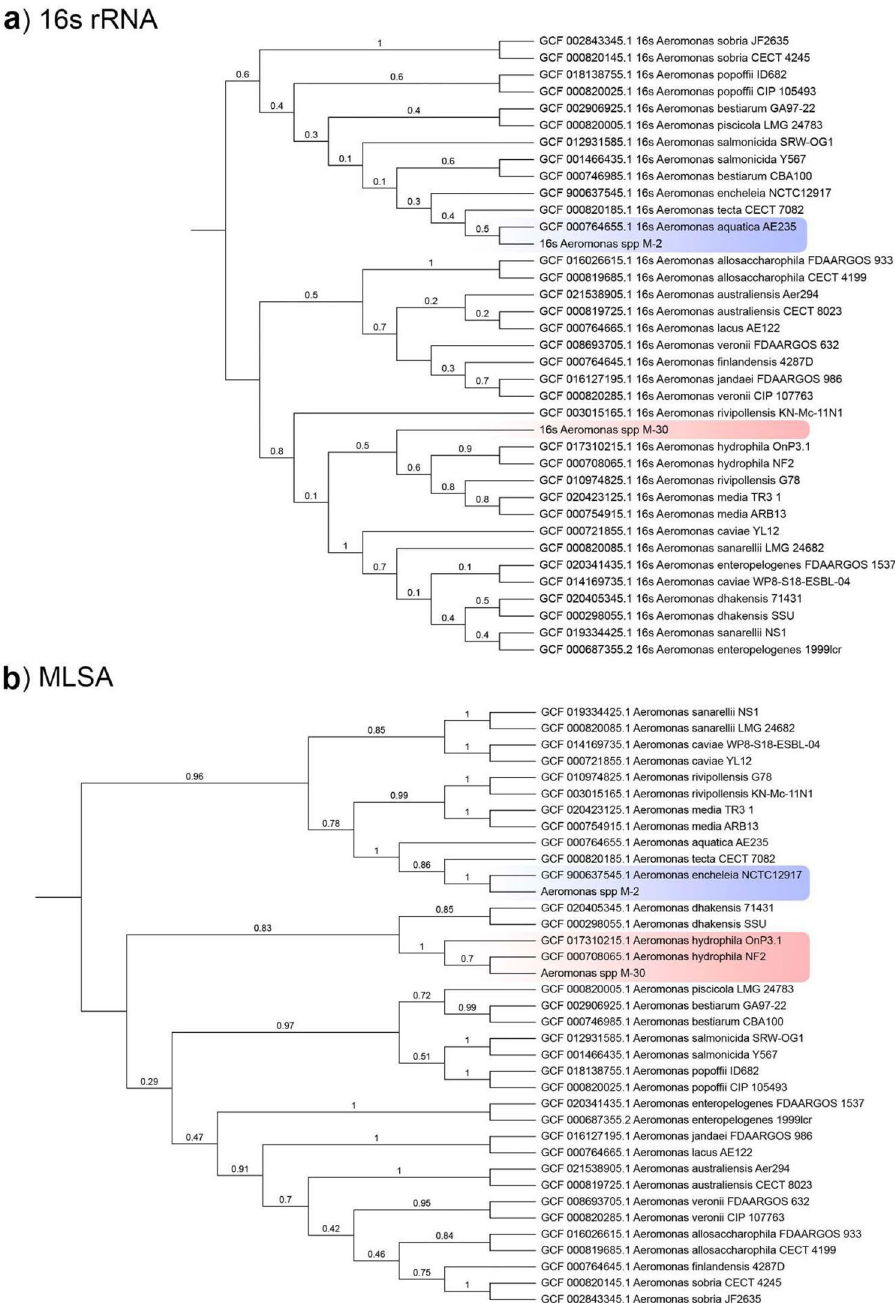
Figure 1. Reconstructed cladograms of M-2, M-30 and 35 Aeromonas spp. strains based on: ( a ) 16 s rRNA gene sequence-based cladogram. ( b ) MLSA based cladogram (5 loci). Cladograms were visualized in Interactive Tree Of Life v5 (iTOL) 34